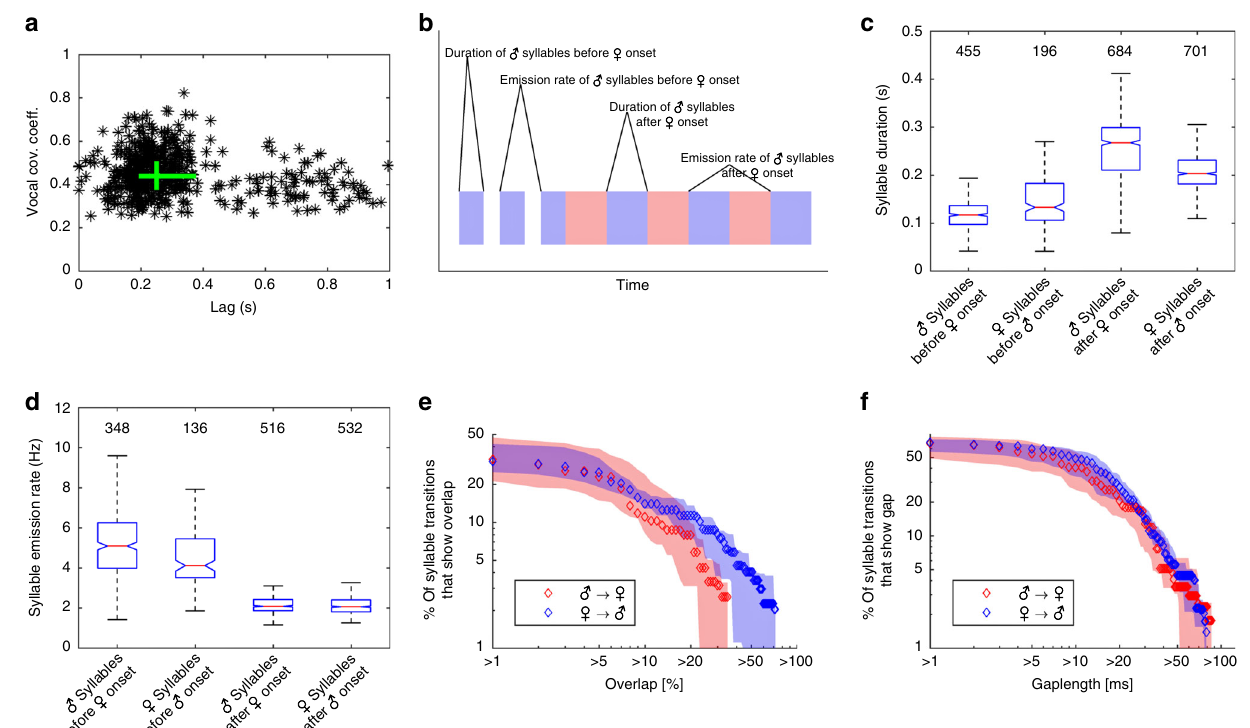
Fig. 3 Quanti fi cation of temporal properties of vocal activity during duetting. a Time lags of maximum cross-covariance between male and female vocal signals (root-mean-square envelopes) during 554 duet bouts produced by 8 bird pairs were clustered at approximately 250 ms. The green lines indicate interquartile ranges of lags and cross-covariance coef fi cients, and their intersection is at the medians of the distributions. b Cartoon of a male-initiated duet bout de fi ning the temporal duet properties that are displayed in c , d . Blue and red rectangles represent male and female duet syllables, respectively. c The duration of syllables sung by a single bird before the second bird ’ s song onset was signi fi cantly shorter than the duration of syllables sung in alternation after the second bird ’ s song onset. Furthermore, male duet syllables were signi fi cantly longer in duration than female duet syllables. In the boxplot, the horizontal red line indicates the median, and the bottom and top edges of the box indicate the 25th and 75th percentiles, respectively. The black whiskers extend to the most extreme data points not considered outliers (outliers are not shown). The extremes of the two notches of the box correspond to y − 1.57( z − x )/ √ n and y + 1.57( z − x )/ √ n , where y is the median, x and z are the 25th and 75th percentiles, respectively, and n is the number of observations. Medians are signi fi cantly different at the 5% signi fi cance level if the boxes ’ notches do not overlap. d The emission rate of syllables sung by a single bird before the second bird ’ s song onset was signi fi cantly higher than the emission rate of syllables sung in alternation after the second bird ’ s song onset. Labeling of boxplots as in c . The median (seven pairs) percentage of duet syllable transitions that showed an overlap ( e ) or a gap ( f ) larger than the value on the x axis is marked by blue and red diamonds for female to male and male to female transitions, respectively. Shaded areas indicate the distributions